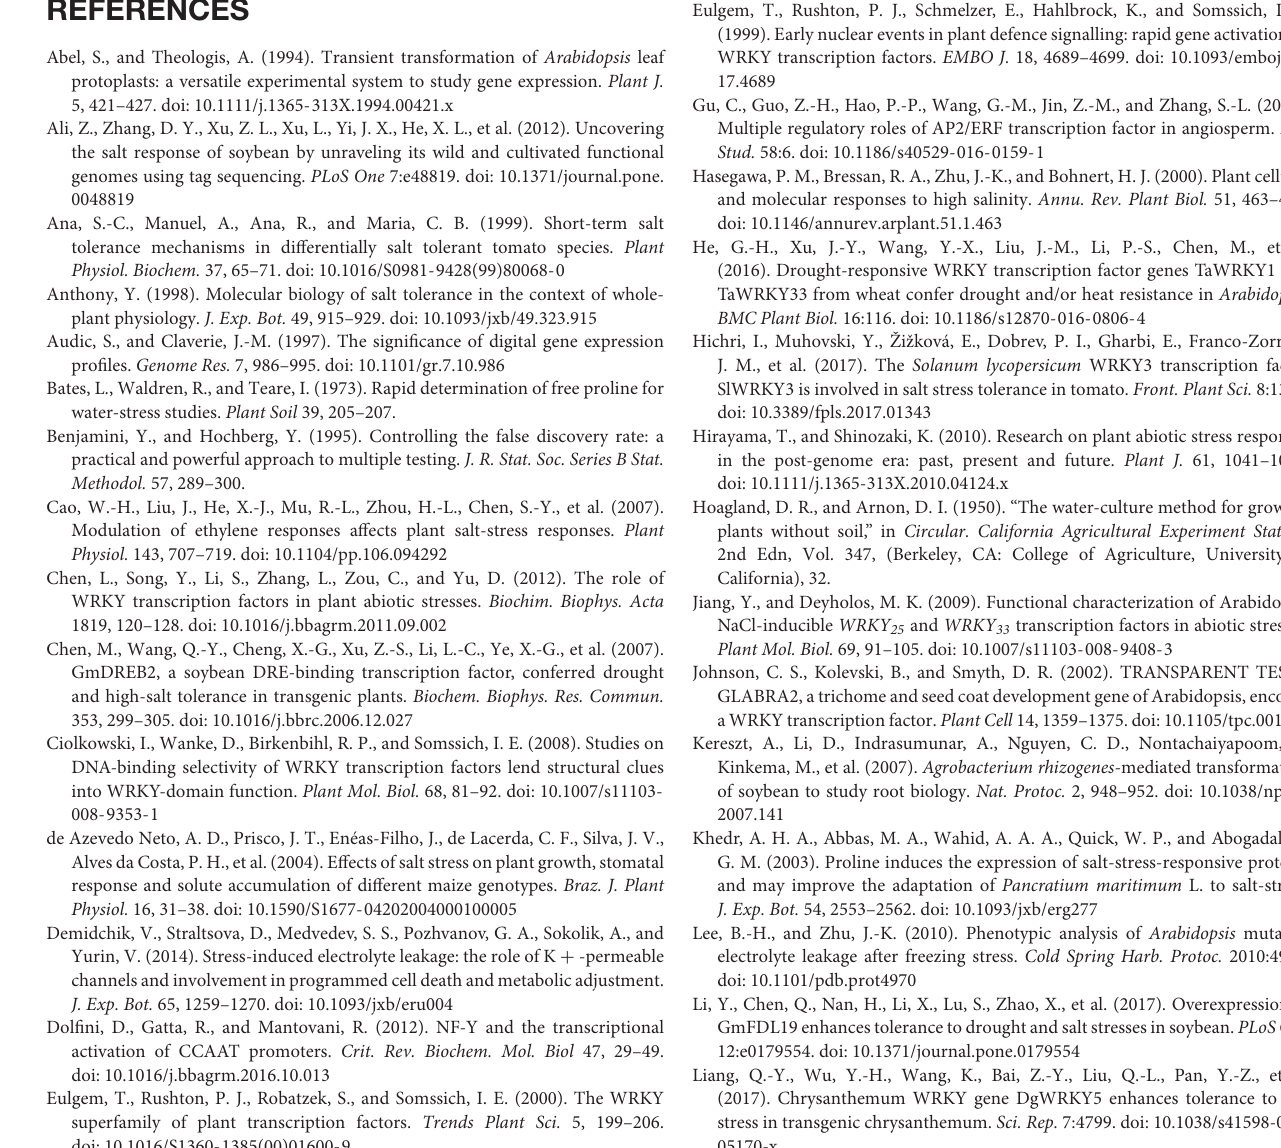
TABLE S2 | Transcript aboundance data of GmWRKY genes from our DGEP